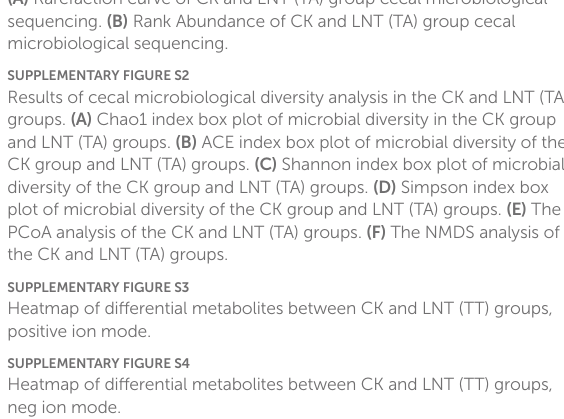
SUPPLEMENTARY FIGURE S1 Rarefaction curve of 16srna sequencing of cecal microorganisms. (A) Rarefaction curve of CK and LNT (TA) group cecal microbiological sequencing. (B) Rank Abundance of CK and LNT (TA) group cecal microbiological sequencing. SUPPLEMENTARY FIGURE S2 Results of cecal microbiological diversity analysis in the CK and LNT (TA) groups. (A) Chao1 index box plot of microbial diversity in the CK group and LNT (TA) groups. (B) ACE index box plot of microbial diversity of the